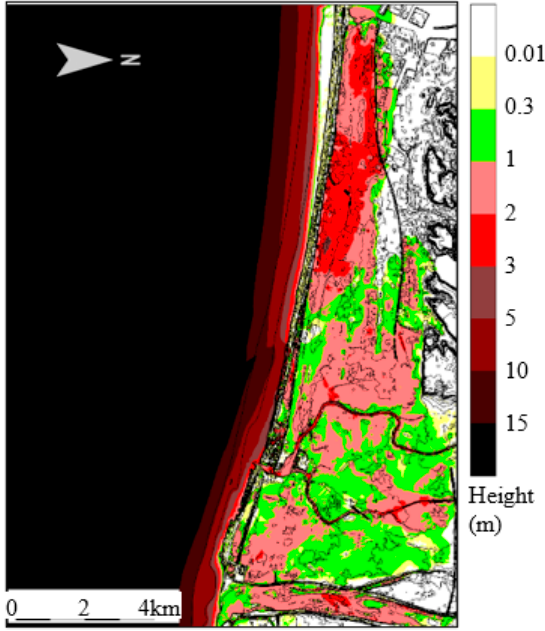
Figure 13. Inundation depths 33 min after the start of calculation (present condition).